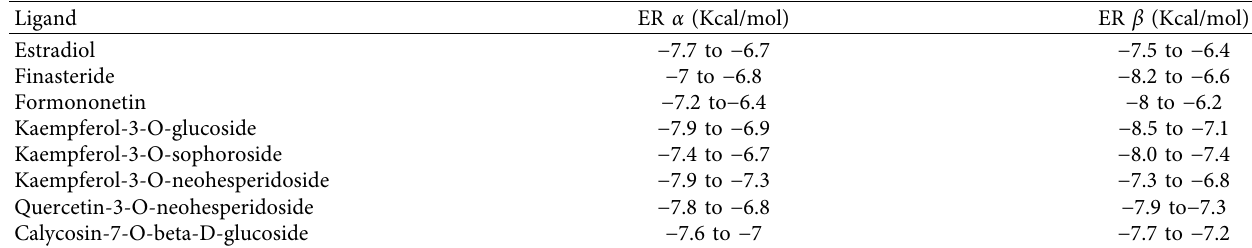
Table 2: Flavonoids present in the extract and their affinity to binding to the ERs α and β . Ligand ER α (Kcal/mol) ER β (Kcal/mol) Estradiol − 7.7 to −